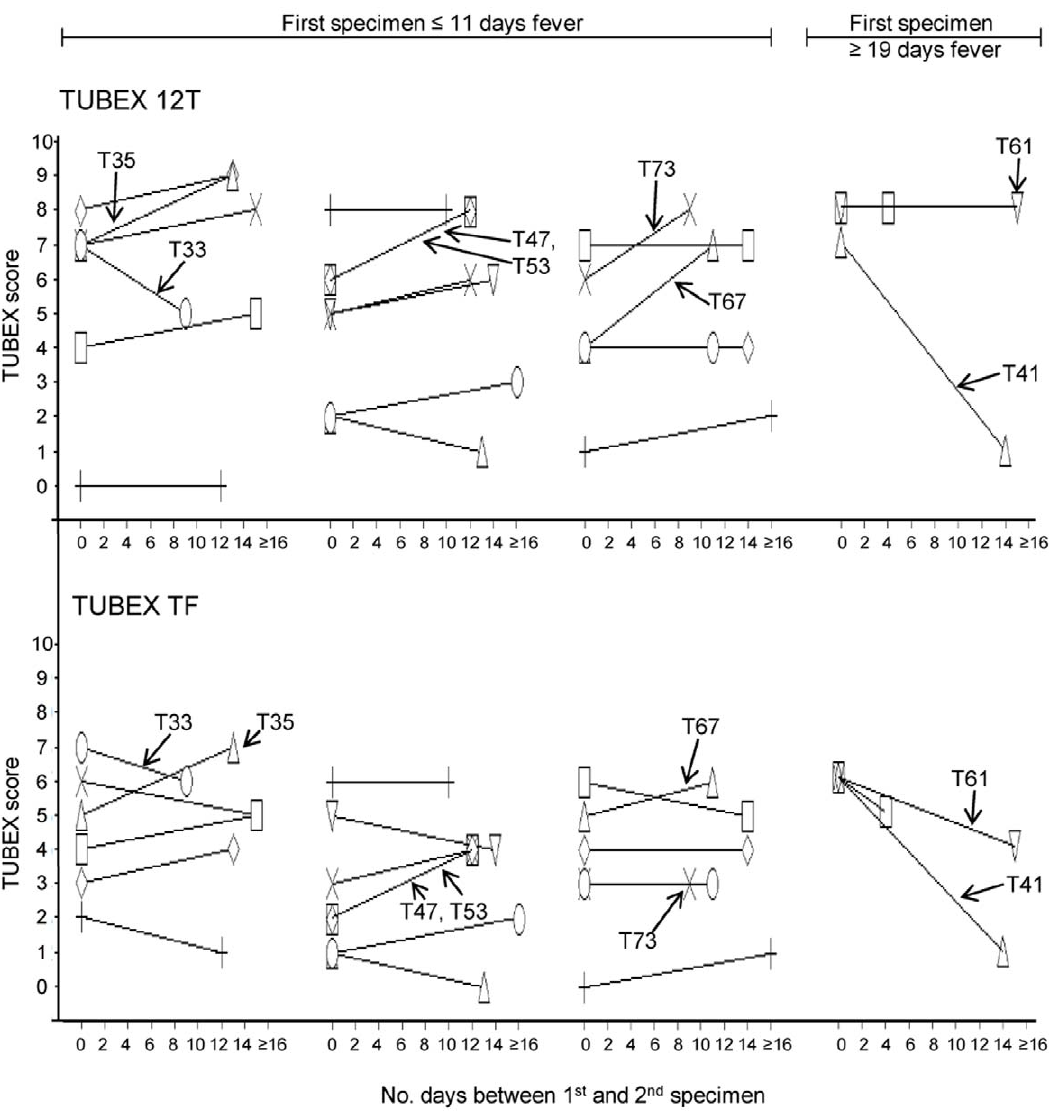
Figure 5. Change in antibody titer (TUBEX score) over time in individual typhoid patients. TUBEX 12T or TUBEX TF was used to examine the 1 st and 2 nd specimen from 22 patients. Cases divided between those whose 1 st specimens were obtained less than 11 days of fever, and those obtained after 19 days; indicated are ones showing significant rise or fall in antibody titer.